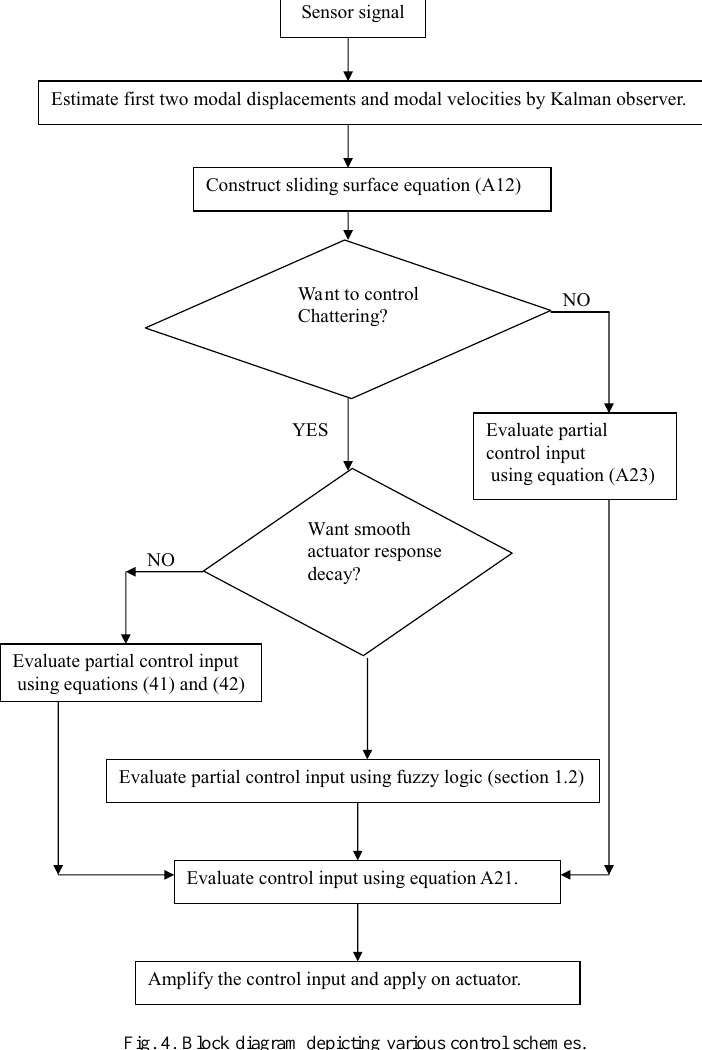
Fig. 4. Block diagram depicting various control